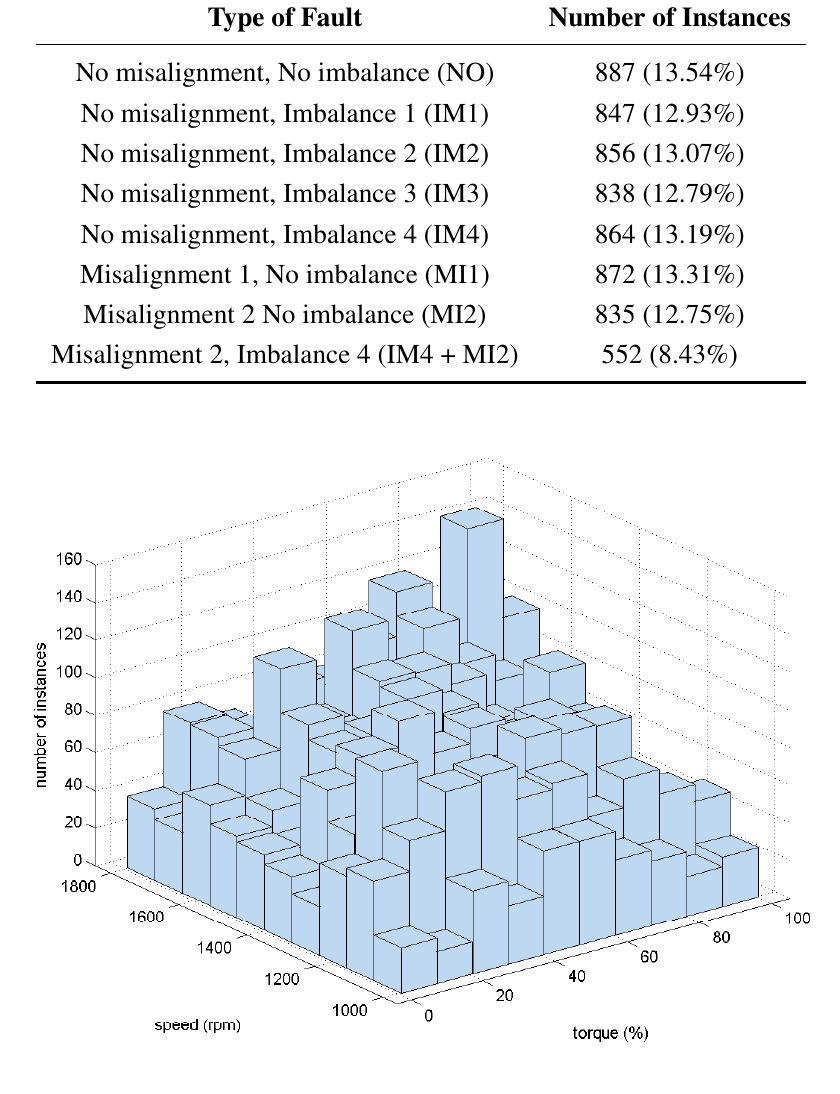
Figure 4. Histogram of the pair (torque,